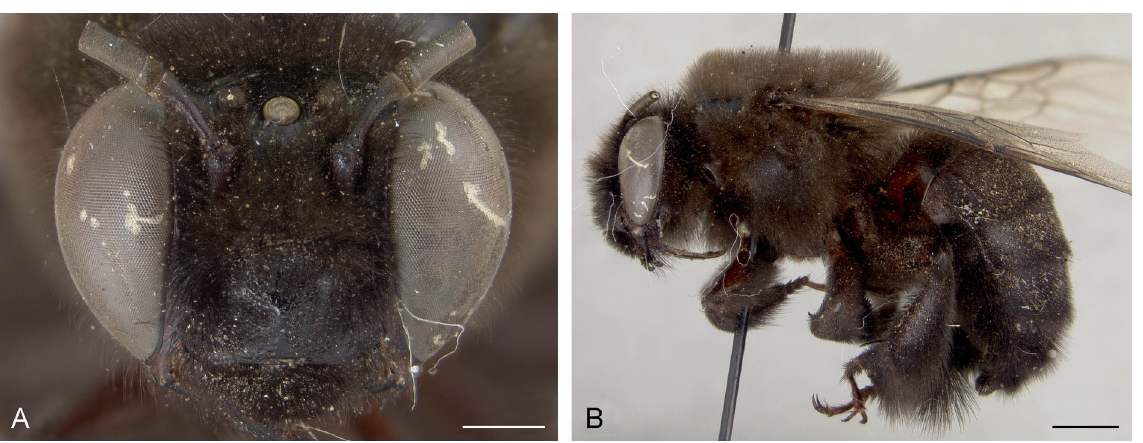
Fig. 29. Centris escomeli Cockerell, 1926, holotype, ♂ (NMNH; USNM ENT 00534193). A . Frontal view. B . Habitus, lateral view. Scale bars: A = 1 mm; B = 2 mm.